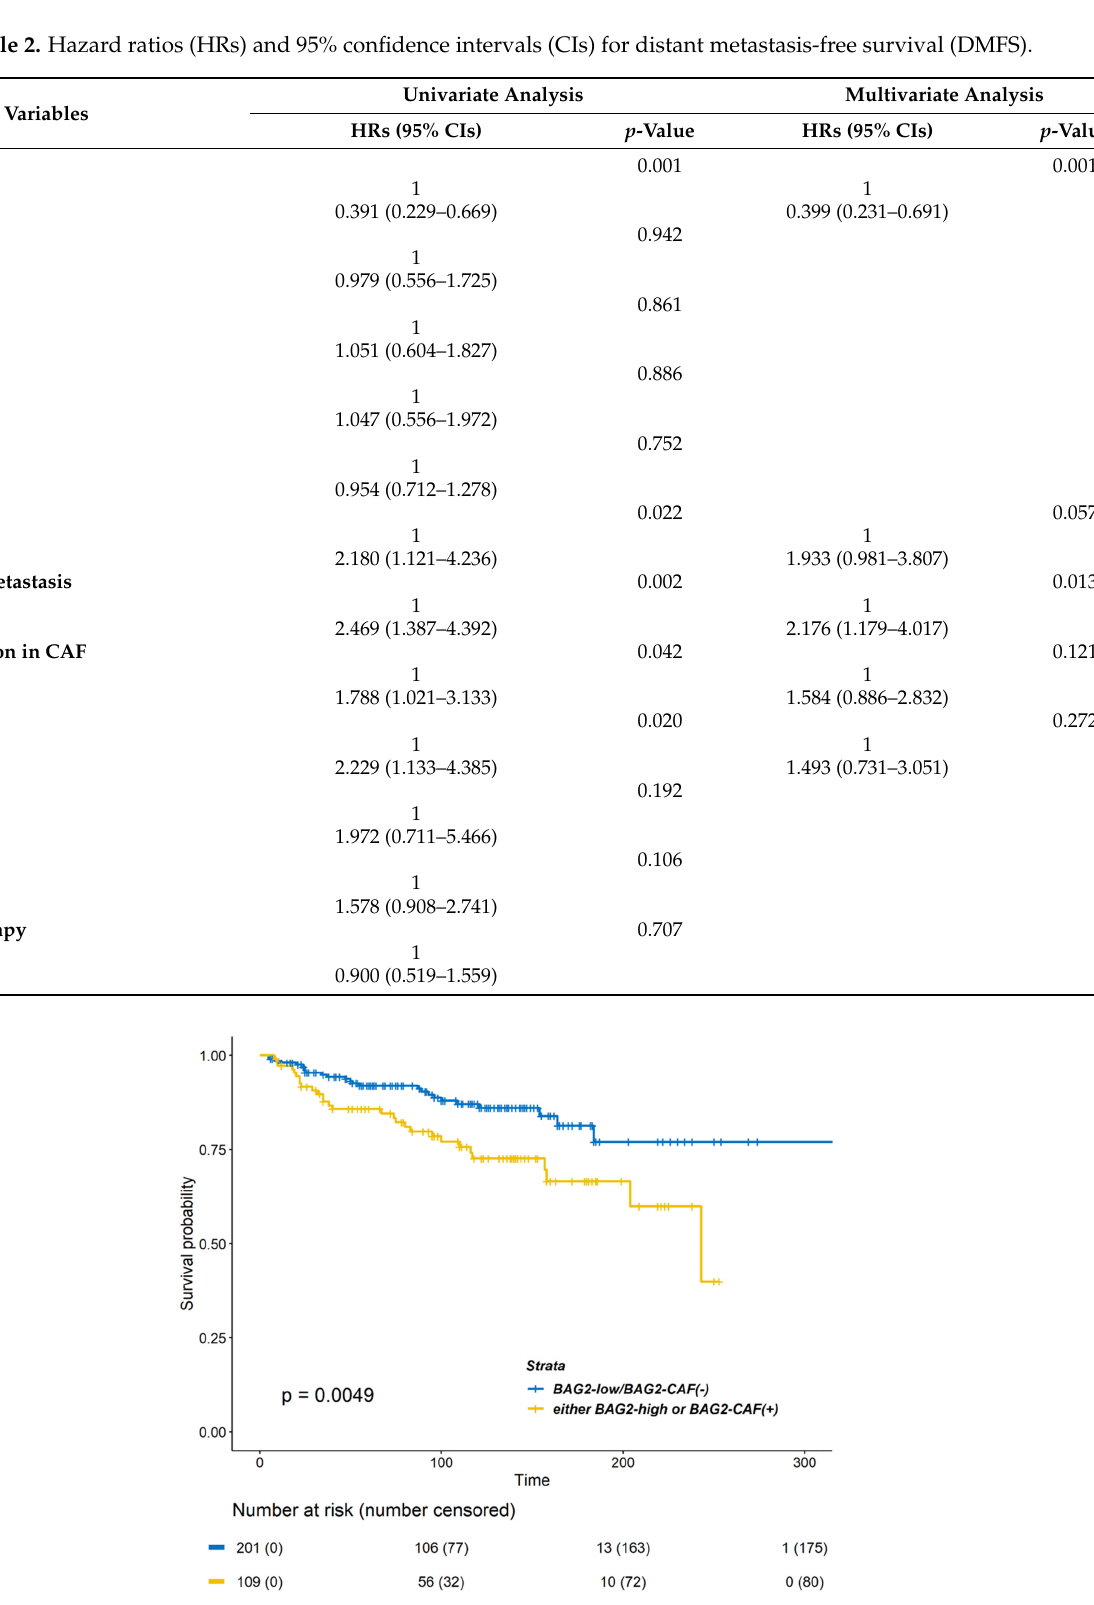
Figure 3. Kaplan–Meier survival curves of DMFS according to BAG2 expression in the cytoplasm and CAF. Patients with strong BAG2 expression (either high cytoplasm BAG2 or positive BAG2 in CAF) showed a poorer DMFS ( p = 0.0049, log-rank test) as compared to patients with double-negative BAG2 expression (low cytoplasm BAG2 and negative BAG2 in CAF). Table 3. Clinical characteristics according to BAG2 expression in cytoplasm and CAF.